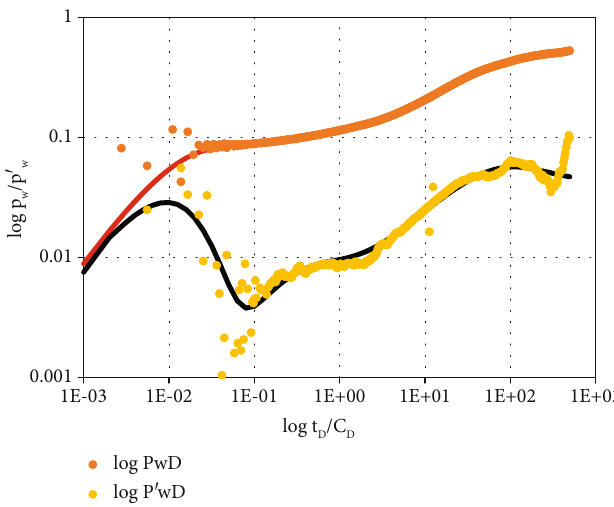
Figure. 4: Double logarithm curve fi tting diagram of well A-21. Table 2: Interpretation results of formation parameters of well A- 21. Formation